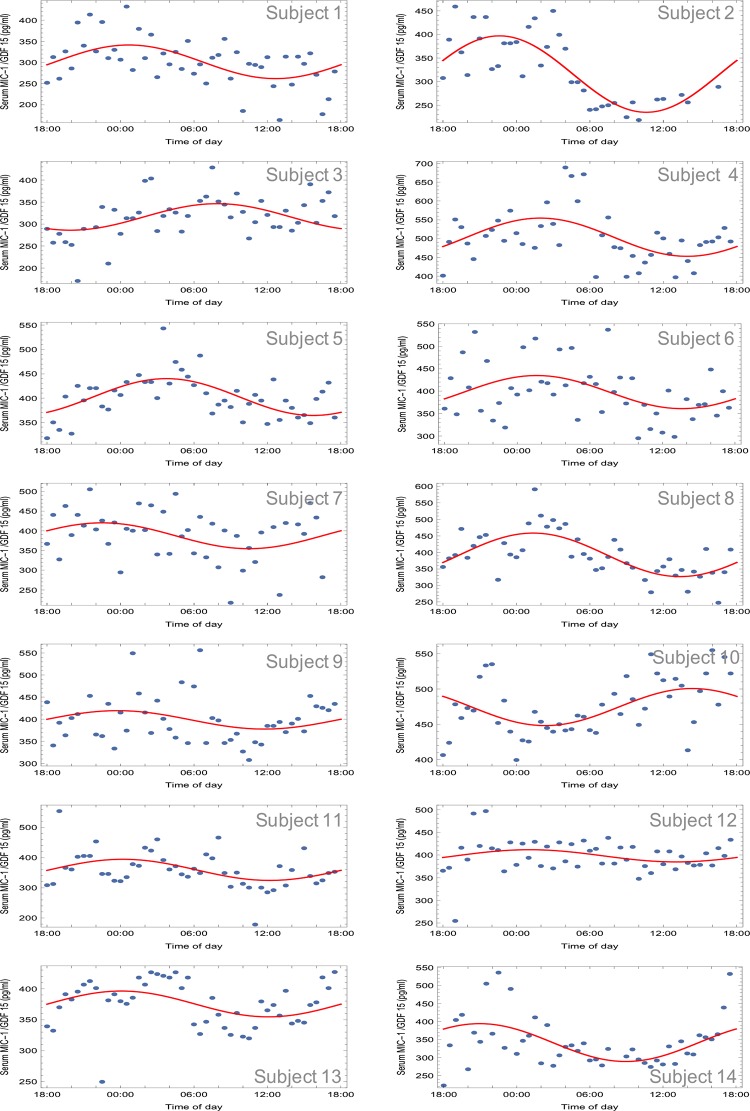
Fasting diurnal variation of human MIC-1/GDF15 serum levels.Serum MIC-1/GDF15 levels were measured on blood sample taken from participants every 30min during a 24h period. The oscillatory pattern of serum MIC-1/GDF15 levels for each individual subject was fitted to a cosine curve function.